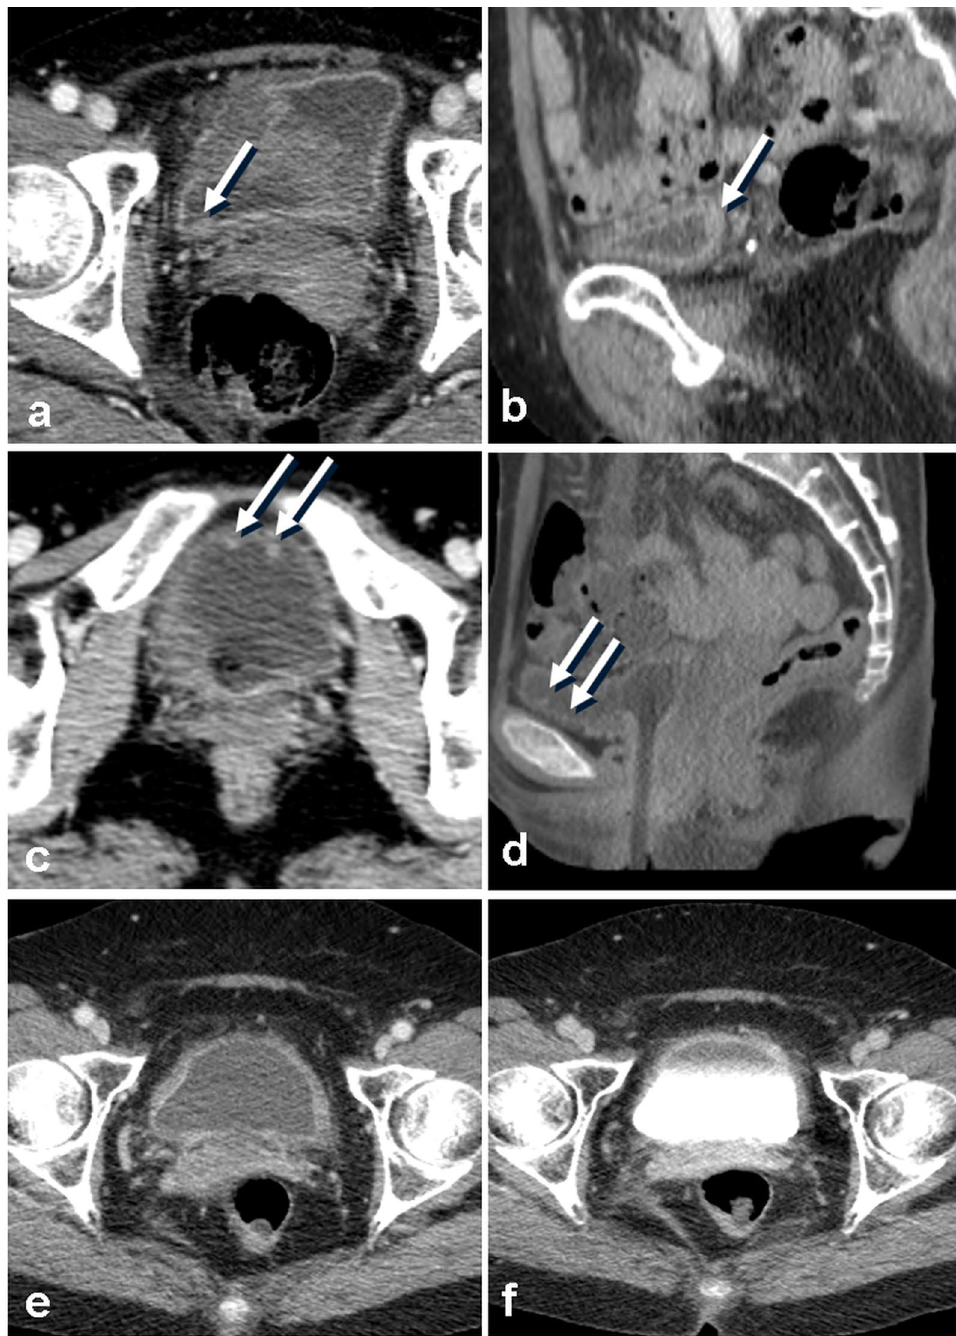
Fig. 3 CT detection of small and flat bladder lesions multiplanar reformation (MPR) in three patients of urothelial carcinoma. Axial ( a ) and sagittal ( b ) urothelial phase CT images of a 73‑year‑old woman showing an enhanced area of focal wall bladder thickening (arrows). Axial ( c ) and sagittal ( d ) urothelial phase CT images of a 58‑year‑old woman showing two tiny enhancing lesions (arrows) on the anterior wall of the bladder. Axial urothelial ( e ) and excretory ( f ) phase CT images of a 71‑year‑old woman showing subtle diffuse or segmental mucosal enhancement of the bladder without filling defects. The patient was diagnosed with urothelial carcinoma in situ on histopathological examination. Small or flat lesions are more difficult to detect with